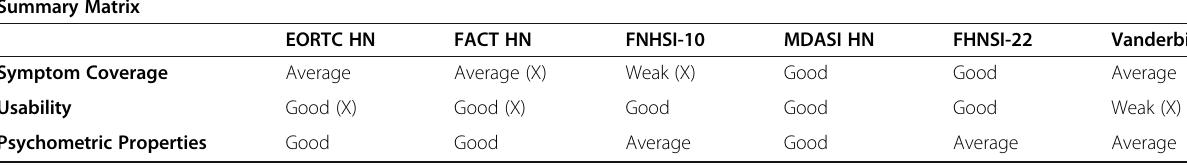
Table 3 PROM selection process summary matrix – head and neck test case Summary Matrix